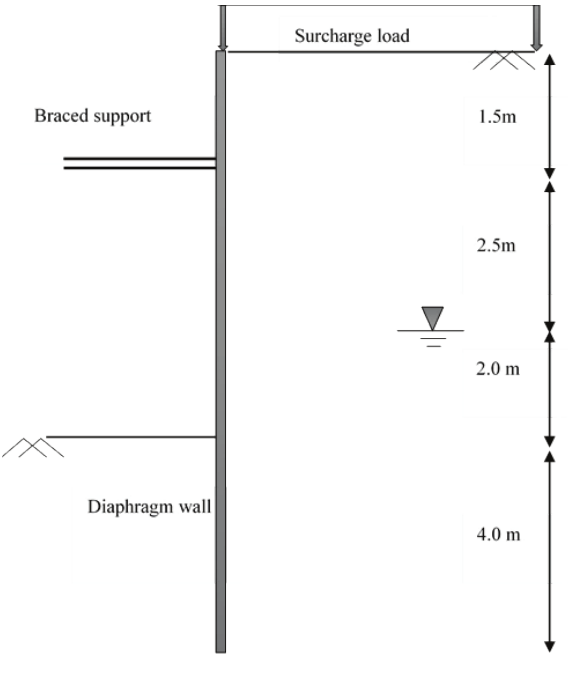
Fig. 1 Strutted diaphragm wall Figure 1: Strutted diaphragm